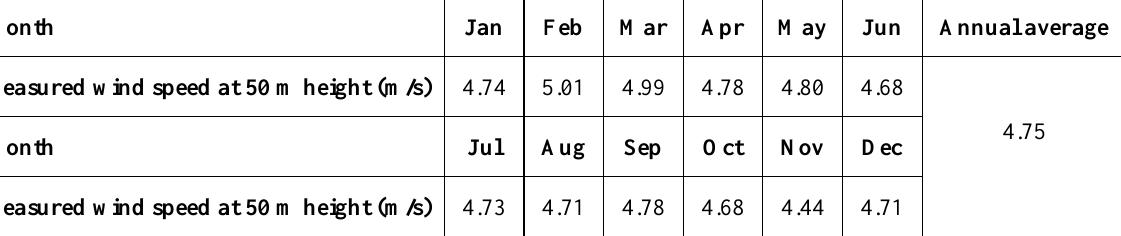
Table 5. Averaged wind speed/month at 50 m from the surface for for the suggested location